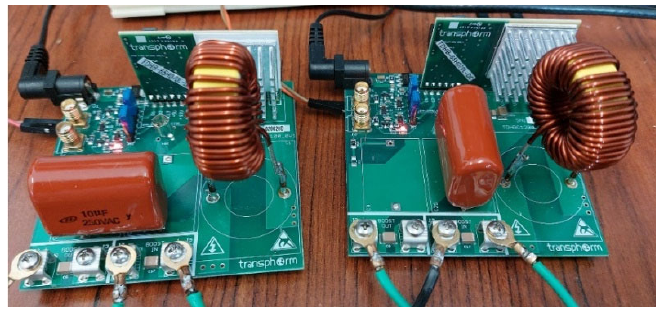
Figure 16. Experimental prototype photo.